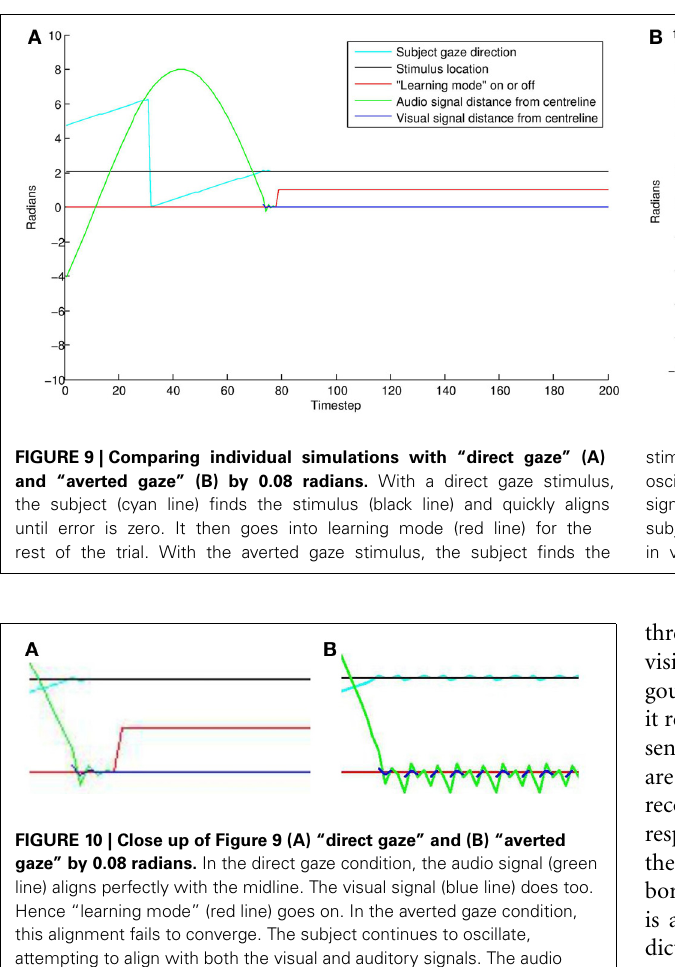
FIGURE 10 | Close up of Figure 9 (A) “direct gaze” and (B) “averted gaze” by 0.08 radians. In the direct gaze condition, the audio signal (green line) aligns perfectly with the midline. The visual signal (blue line) does too. Hence “learning mode” (red line) goes on. In the averted gaze condition, this alignment fails to converge. The subject continues to oscillate, attempting to align with both the visual and auditory signals. The audio (green line) and visual (broken blue lines) signals oscillate around good alignment without ever both achieving it. Thus the subject never enters learning